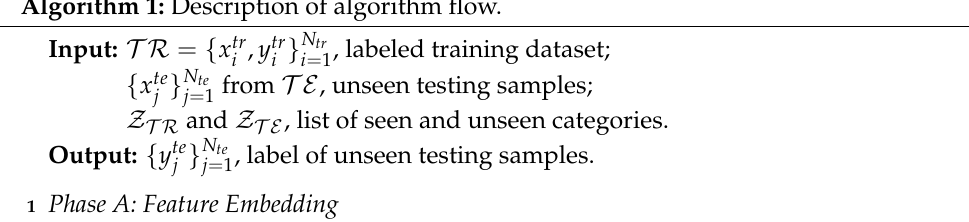
Algorithm 1: Description of algorithm